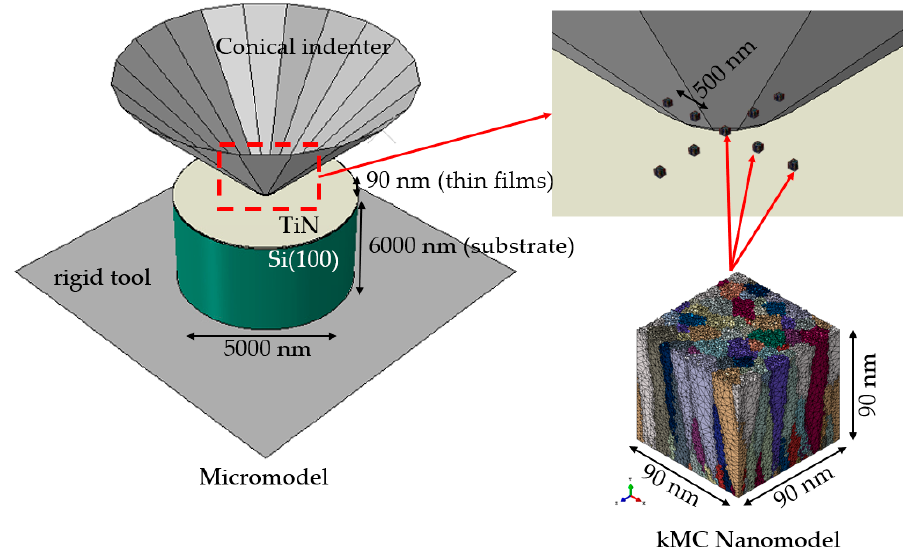
Figure 9. Schematic illustration of the multiscale model of the nanoindentation test.